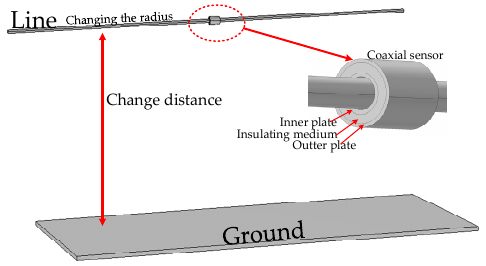
Figure 3. COMSOL simulation model.